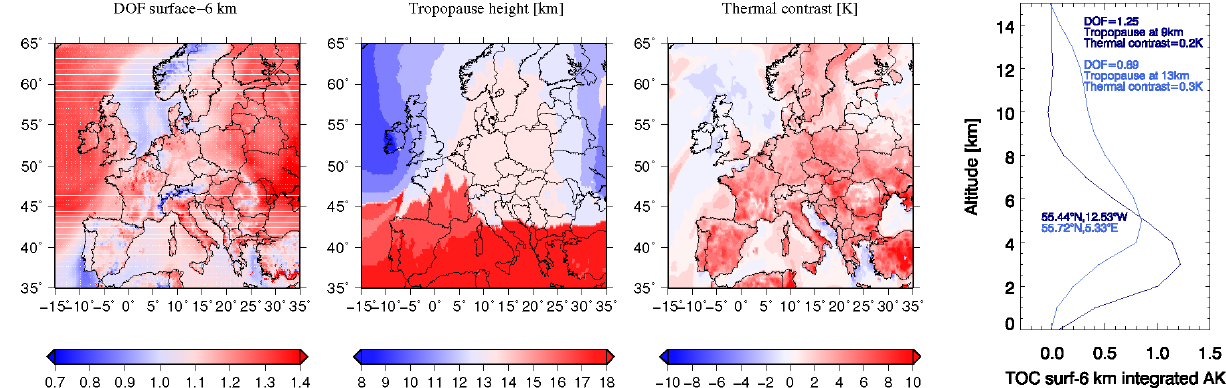
Fig. 5. Distribution over Europe of the full RT DOFs surface-6km for full RT (left panel), and tropopause height (centre-left panel) and thermal contrast (centre-right panel) from MOCAGE NR, for the 20 August 2009, 09:00UTC. The surface-6km ozone column integrated AKs, for two selected locations, are also shown (right panel).